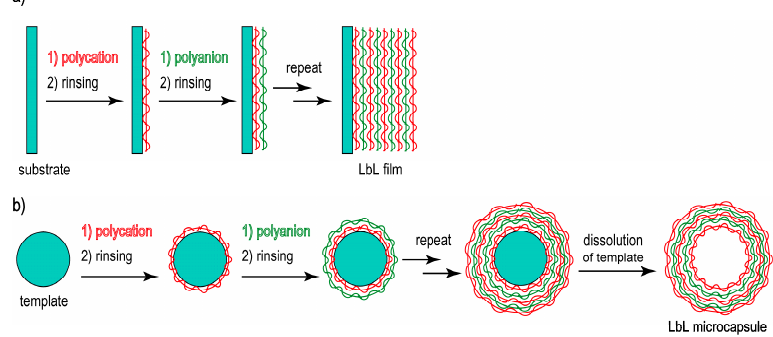
Figure 1. Preparation of layer-by-layer (LbL) films ( a ) and microcapsules ( b ).